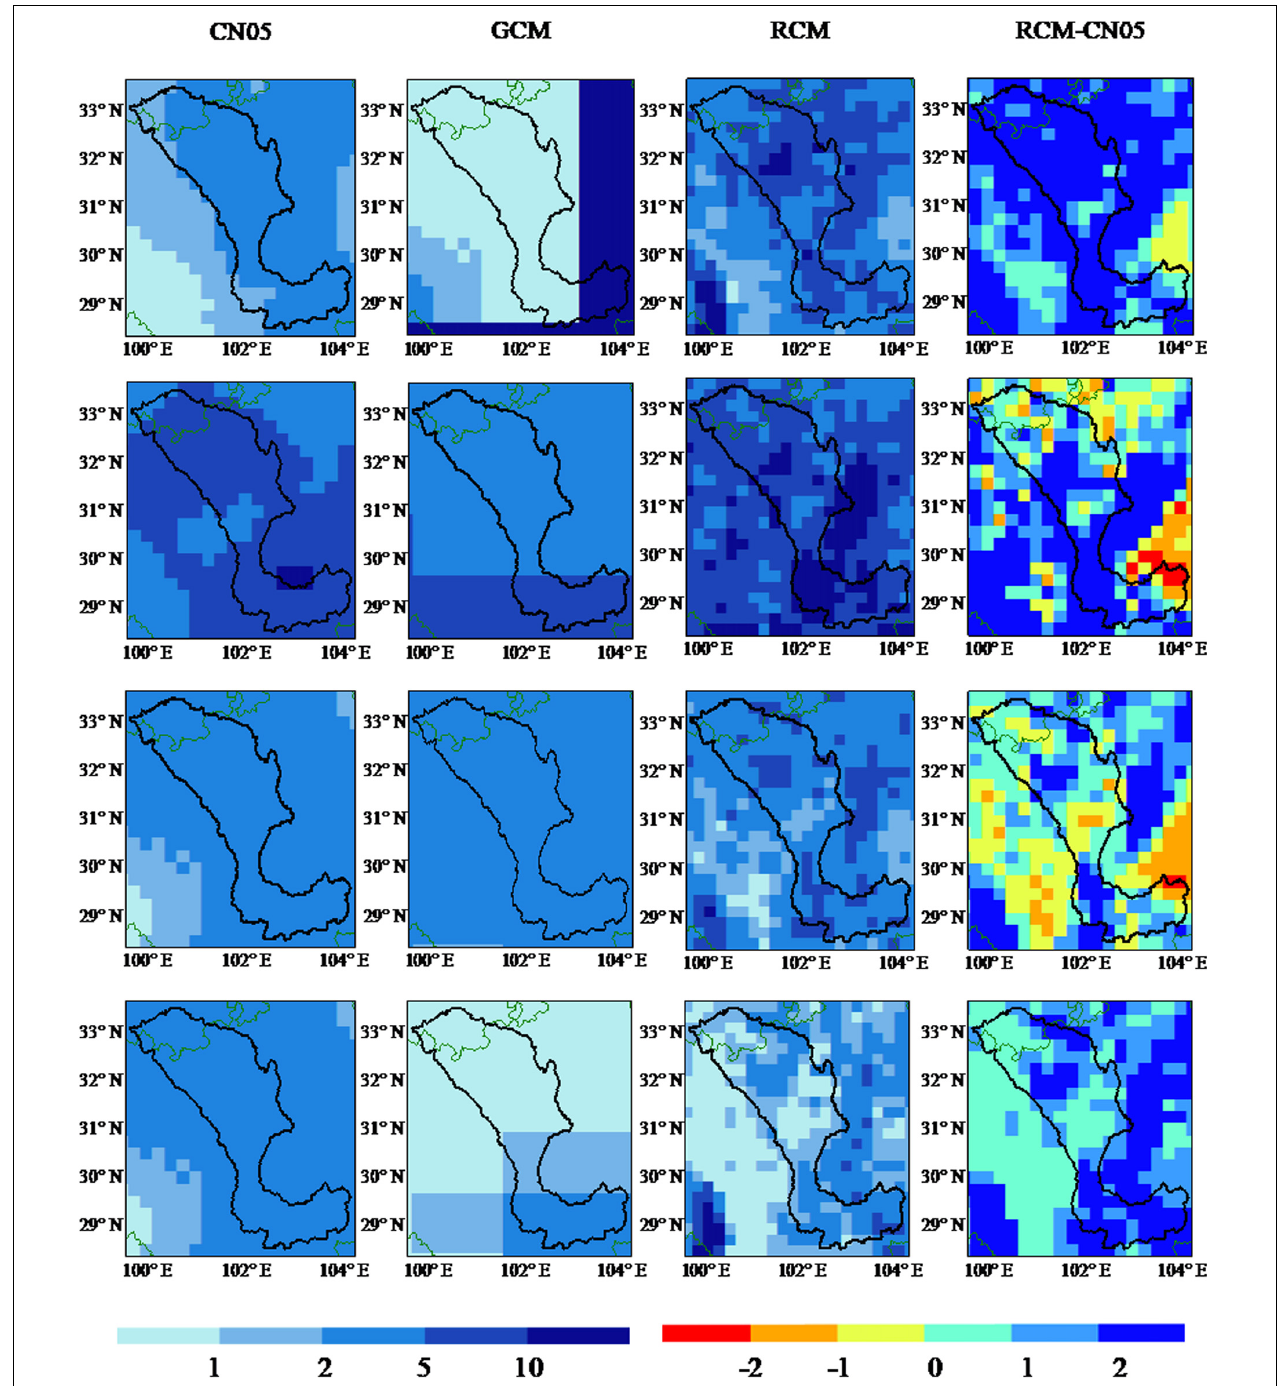
FIGURE 6 | Simulation results and deviation of difference scale models in each